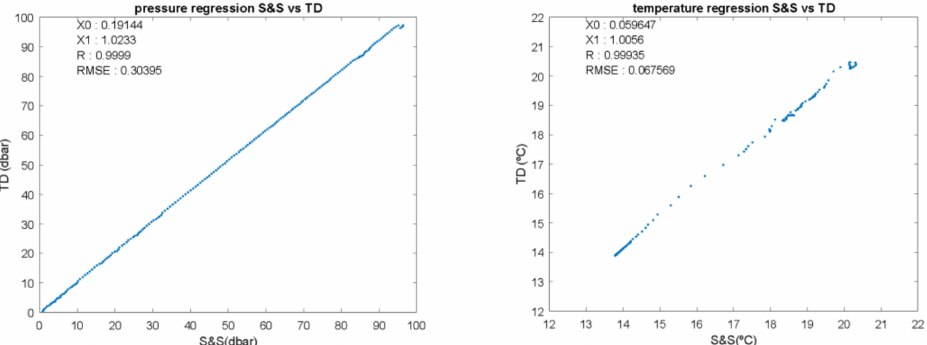
Figure 6. Regression plots for ( left ) pressure and ( right ) temperature between the PV TD and Sea & Sun CTD 48Mc